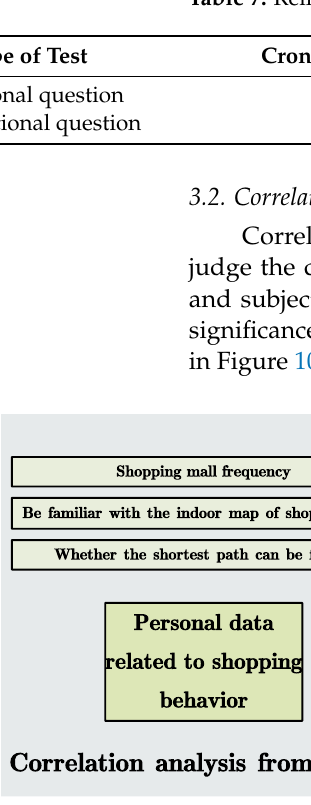
Table 7. Reliability and validity analysis of forward and reverse problems of Kano model.